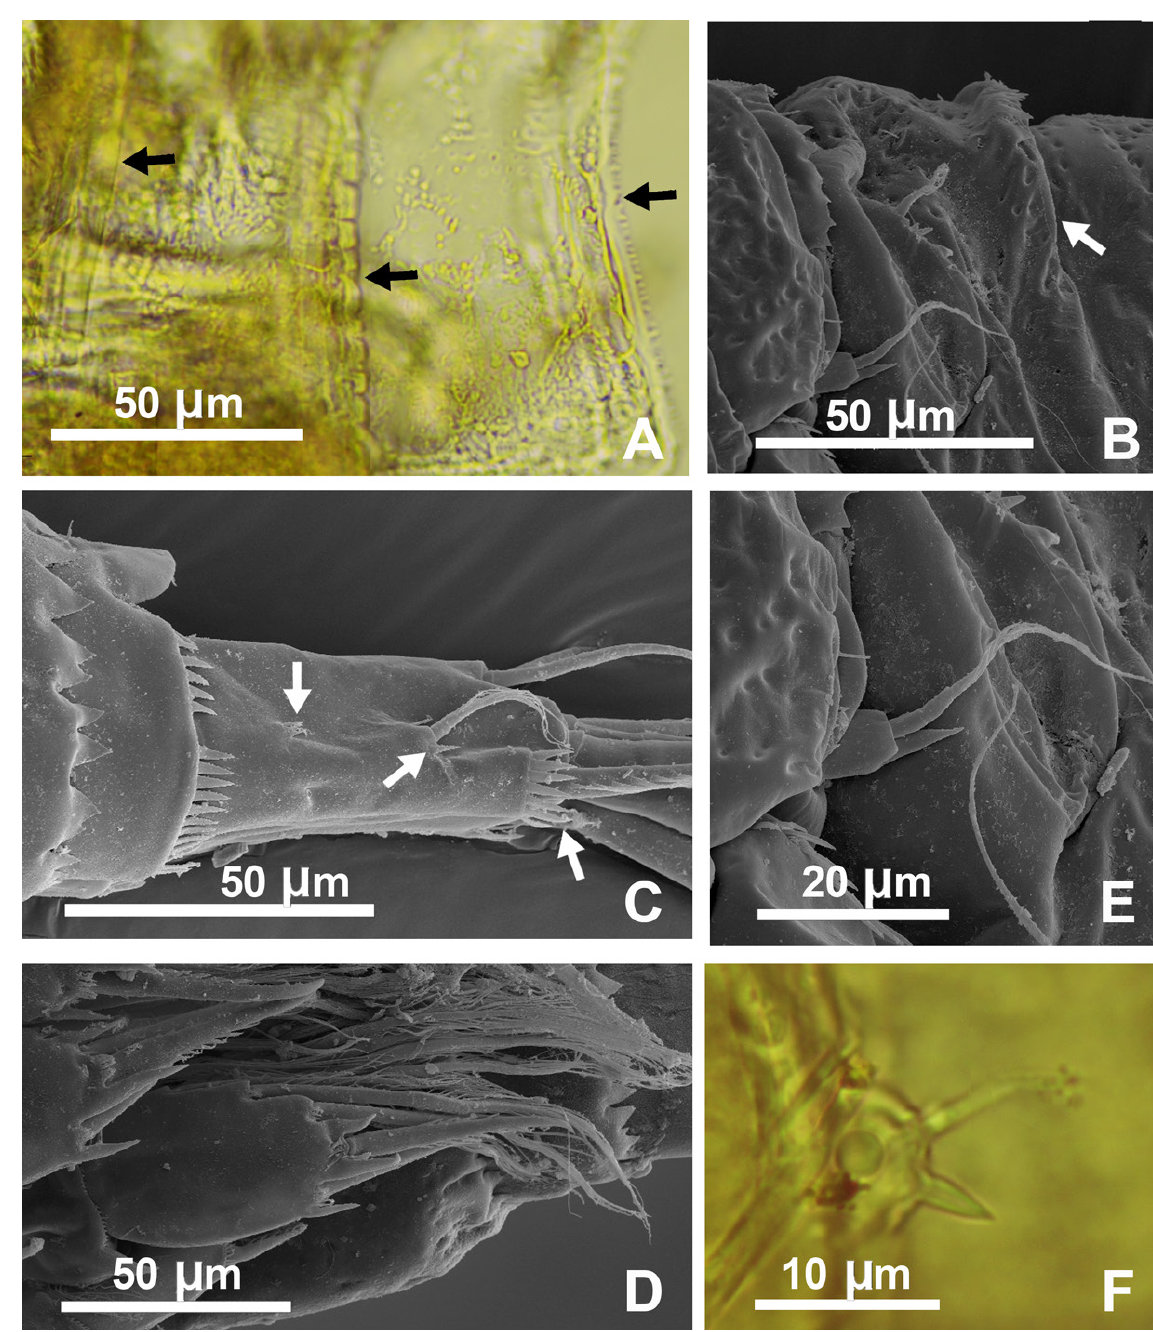
Fig. 4. Metacyclops sakaeratensis sp. nov., digital photographs of allotype, ♂ (A, F; ZMB 34230 slide No. 5121) and SEM photographs of additional material, ♀♀ (B−E; collection of the third author CB). A . Posterior margins of cephalothorax and two subsequent pedigerous somites, dorso-lateral view (arrows indicate posterior margin of the second, third and fourth pedigerous somites). B . Anterior part of genital double-somite, lateral view (arrow indicates posterior margin of the transverse suture). C . Caudal ramus, lateral view (arrows indicate spinules). D . P4 enp-2, frontal view. E . P5, ♀, lateral view. F . P6, ♂, lateral